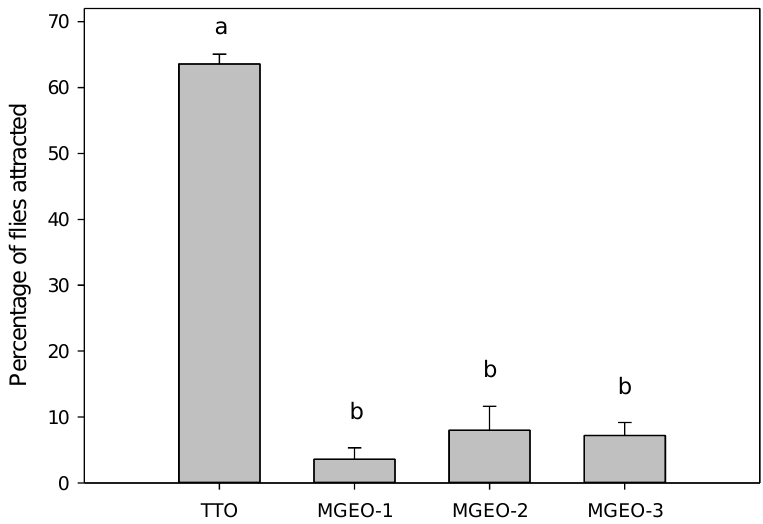
Figure 3. Attraction (mean ± SE) of male Mediterranean fruit flies to mastic gum essential oils (MGEOs 1–3) and tea tree essential oil (TTO, positive control) in short-range bioassays (observed at 30 min). Bars topped with the same letter are not significantly different (Tukey HSD mean separation, P < 0.05).